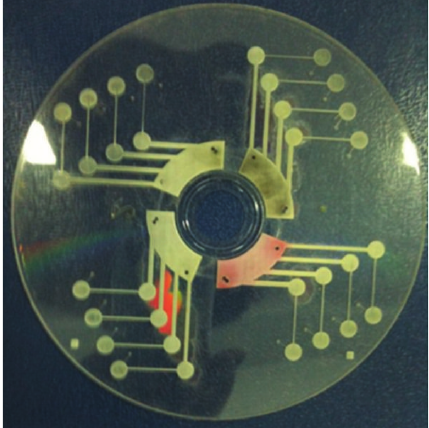
Figure 6: The microfluidic disk.